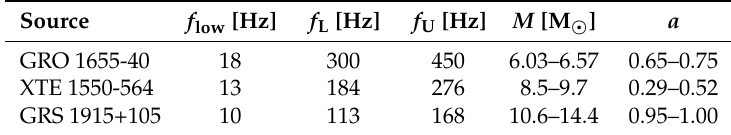
Table 2. Observed QPOs data for three microquasars and the restrictions on mass M and spin a of the black holes located in them, based on measurements independent of the